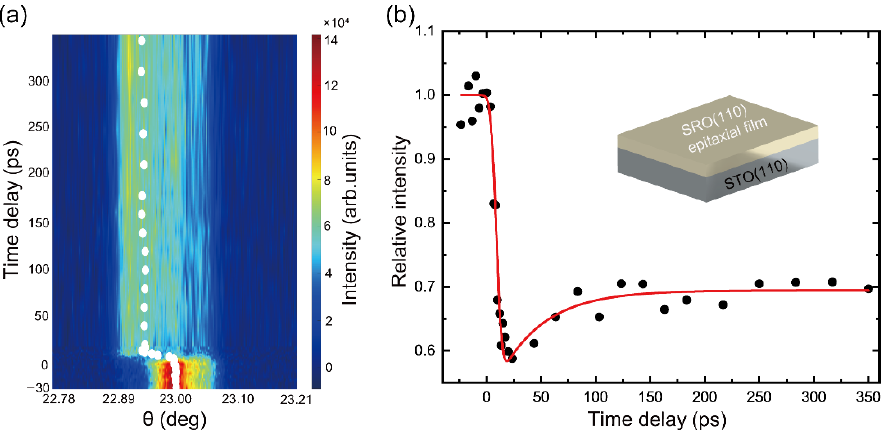
Figure 4. ( a ) Transient θ –2 θ scans for different delay times of − 30 ps < t < 350 ps. The white dotted line indicates the center of the Bragg peaks. ( b ) Normalized relative Bragg peak intensity variation of a 105-nm SRO (110) film with different pump-probe time delays, the solid red line represents an exponential data fitting.